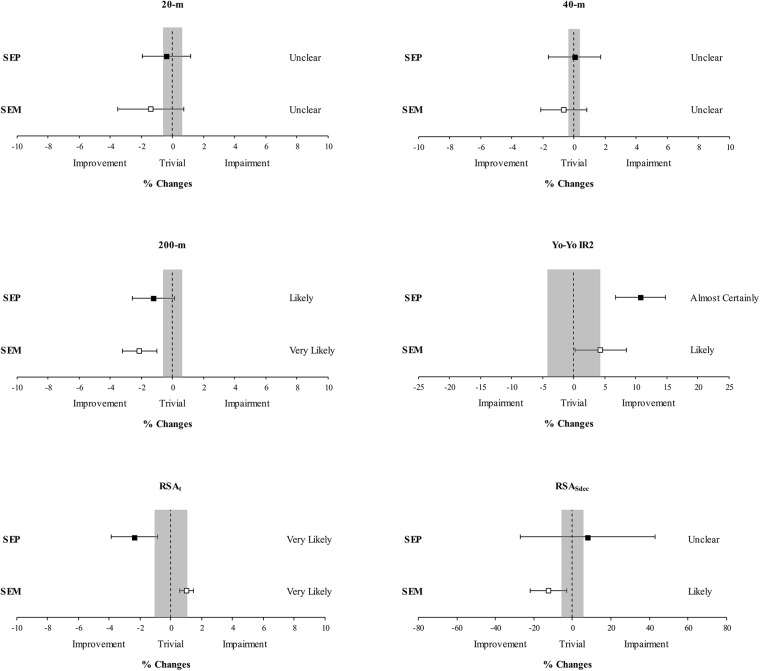
Relative changes for 20-m, 40-m and 200-m sprint time, Yo-Yo IR2 distance, total sprint time (RSAt) and percentage decrement score (RSASdec) of the repeated sprint ability test following speed endurance production (SEP) and speed endurance maintenance (SEM) training (bars indicate 90% confidence intervals).Trivial area was computed from the smallest worthwhile change (see methods).